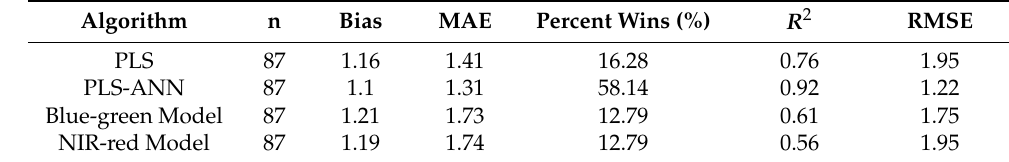
Figure 5. Linear relationship between the PLS components and the chlorophyll-a scores. Table 1. Performance metrics for the four algorithms in retrieving chl- a concentration in the WBLE.